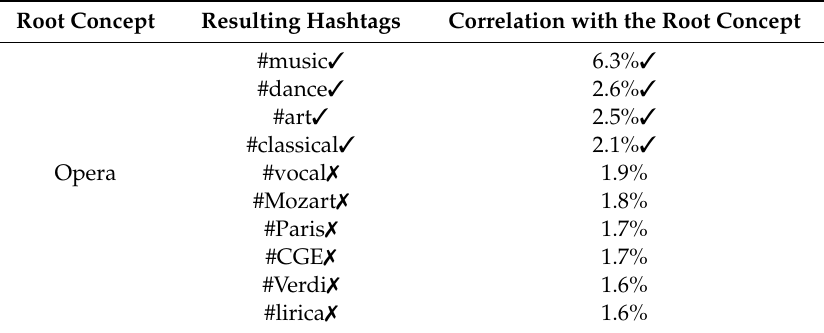
Figure 1. Ontology of class concept entertainment. Table 1. Hashtags generated for opera by Hashtagify [32].